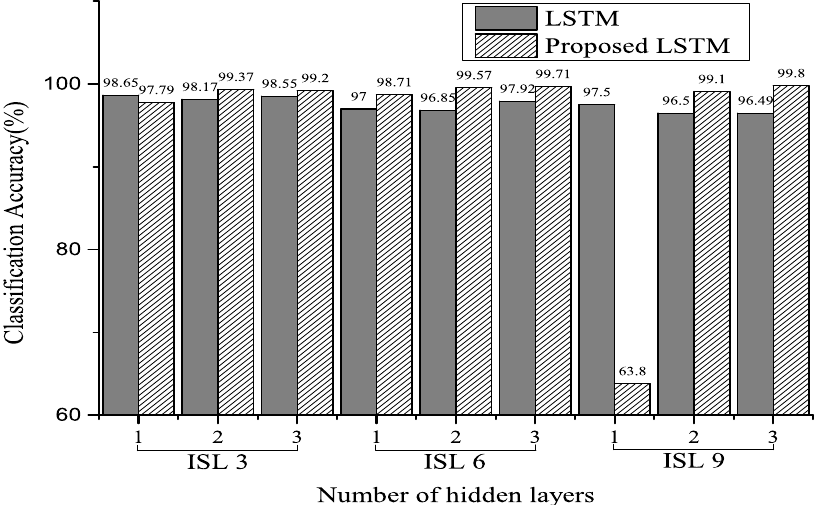
Figure 10. Classification accuracy for MITDB using selected parameters of 250 hidden units. The input sequence length (ISL) is 3, 6, and 9 for the number of heartbeats (Experiment